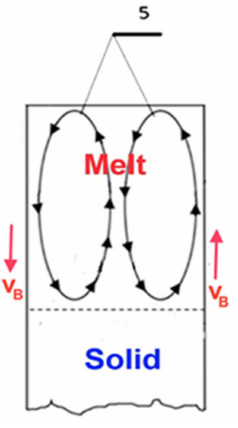
Figure 3. Flow images developed by the TMF twin